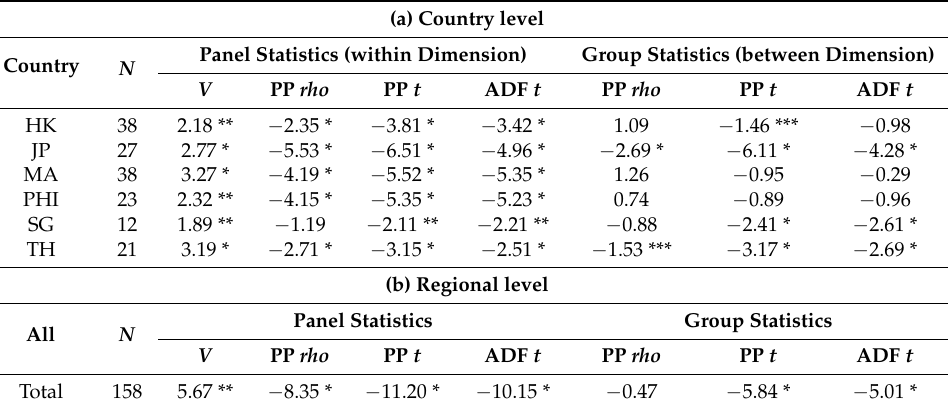
Table 3. Results for panel co-integration test